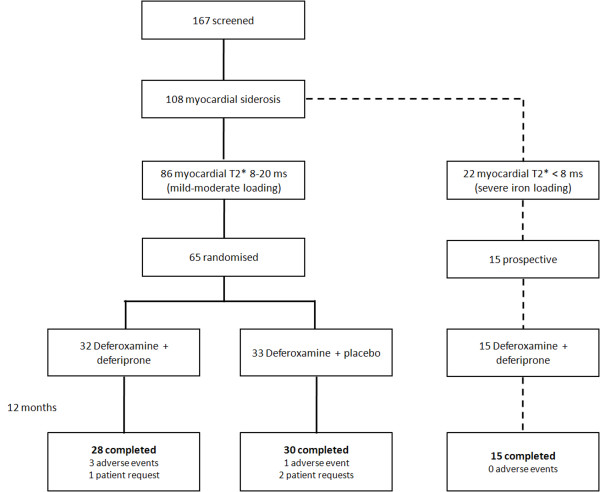
Study flow-chart.